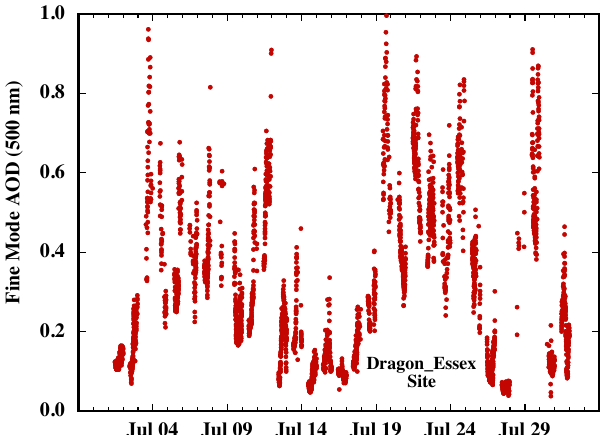
Figure 2. Fine mode AOD at 500nm determined from the spectral deconvolution algorithm (SDA) utilizing measured direct sun AOD spectra from 380 to 870nm as input, from all measurements taken at the DRAGON_Essex site (near Baltimore) during July 2011. These data have not been screened for clouds (Level 1 data), since SDA identifies cloud optical depth as coarse mode AOD. Instantaneous fine mode 500nm AOD ranged from 0.04 to 1.00 over the entire month. Note that this Level 1 AOD data does have final calibrations applied, however, as does all Level 1 data analyzed in this